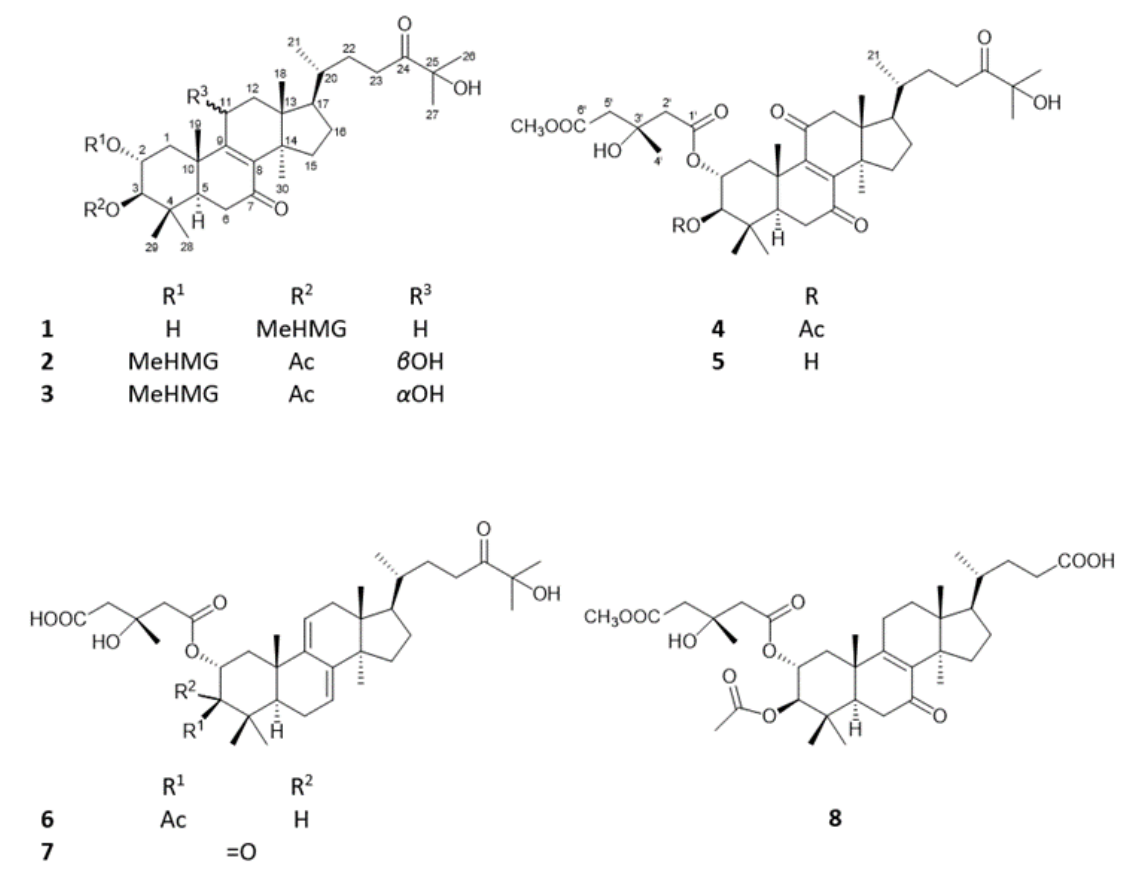
Figure 1. Pholiols L-S ( 1 – 8 ) isolated from Pholiota populnea. MeHMG = 3-hydroxy-3-methyl-glutaryl 6-methyl ester.